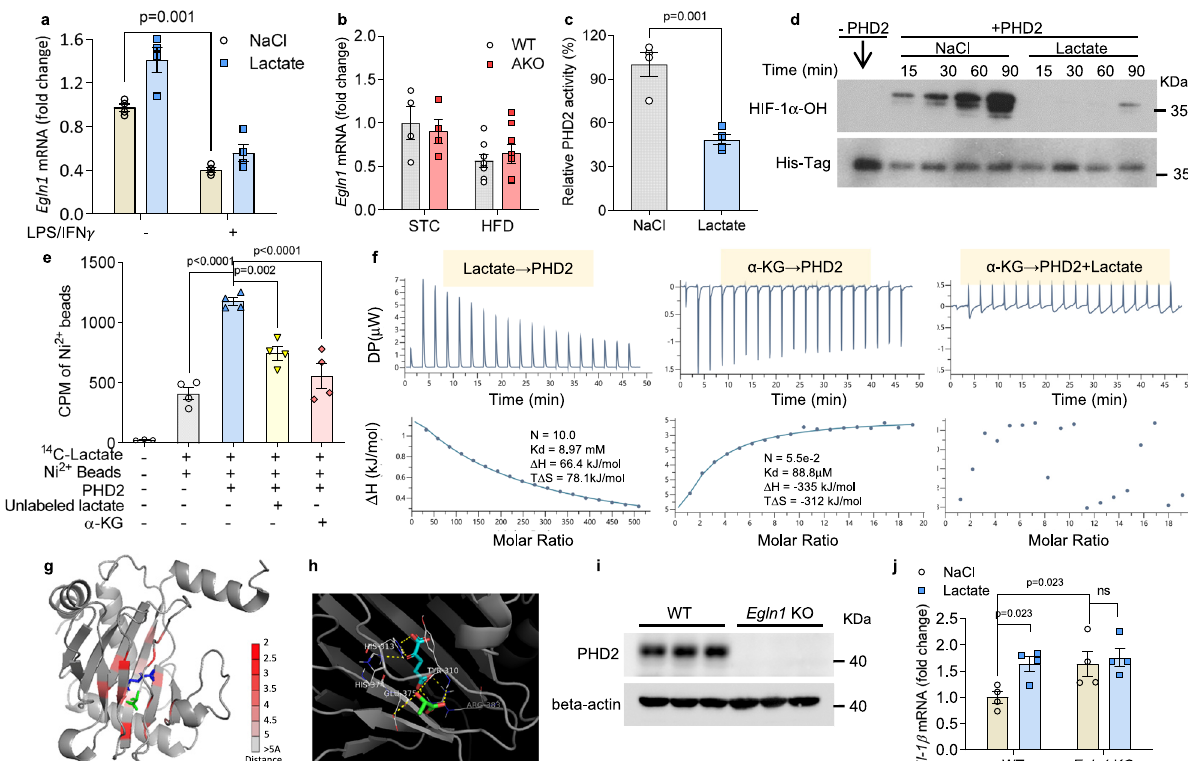
Fig. 6 | Lactate directly binds and inhibits the activity of PHD2. a Egln1 mRNA level in macrophages with 20mM lactate or NaCl. n =4 biologically independent samples. b mRNA of Egln1 in epididymal white adipose tissue (eWAT) of wildtype (WT) and adipocyte-speci fi c Ldha knockout (AKO) mice. STC-WT: n =4; STC-AKO: n =4; HFD-WT: n =8; HFD-AKO: n =8 biologically independent animals. c In vitro fl uorometric PHD2 activity assay in the presence of 20mM lactate or NaCl. n